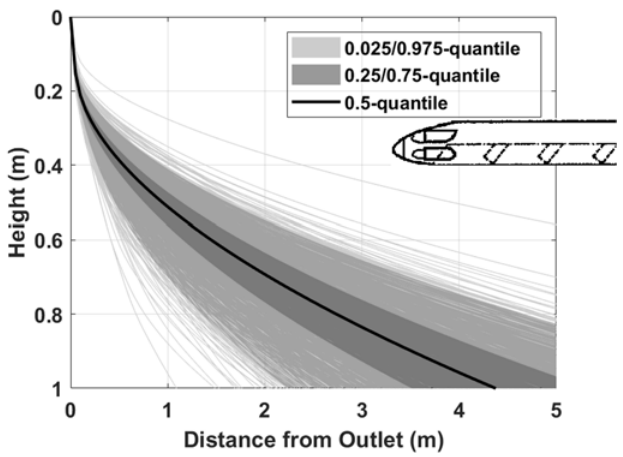
Figure 16. Trajectories of shell cases ejected from two ‐ seater fighter aircraft without